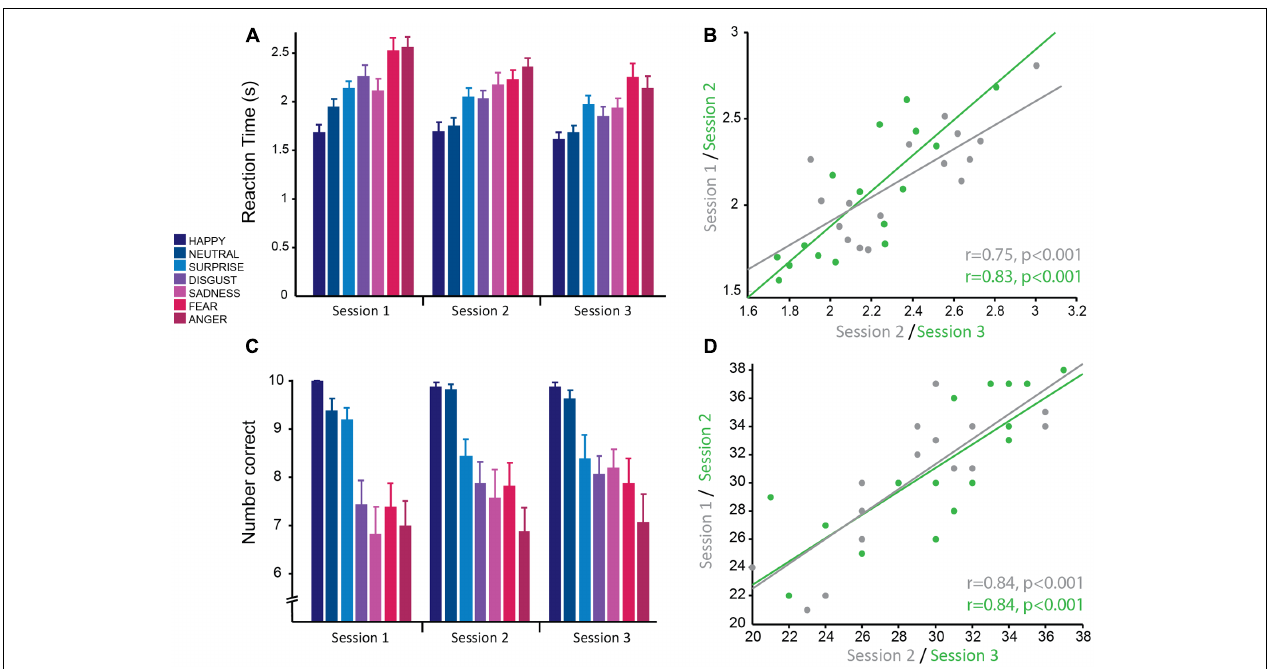
FIGURE 2 | Emotion recognition task: good reliability of reaction times and accuracy across testing sessions. (A) Reaction time from the presentation of the stimulus to selecting the correct emotion averaged across subjects for each session. Reaction times were significantly faster for more positive emotions and slower for more negative emotions. Overall average reaction times decreased across sessions. (B) Significant positive correlation of mean reaction time, averaged over all negative emotions for each subject, between sessions 1 and 2 (gray) and sessions 2 and 3 (green) demonstrating good test–retest reliability. (C) Mean accuracy (number of faces correctly identified for each emotion) averaged across subjects for each session. Accuracy was greater for more positive emotions and less for negative emotions. Accuracy was stable across testing sessions. (D) Significant positive correlation of mean accuracy averaged over all negative emotions for each subject, between sessions 1 and 2 (gray) and sessions 2 and 3 (green) demonstrating good test–retest